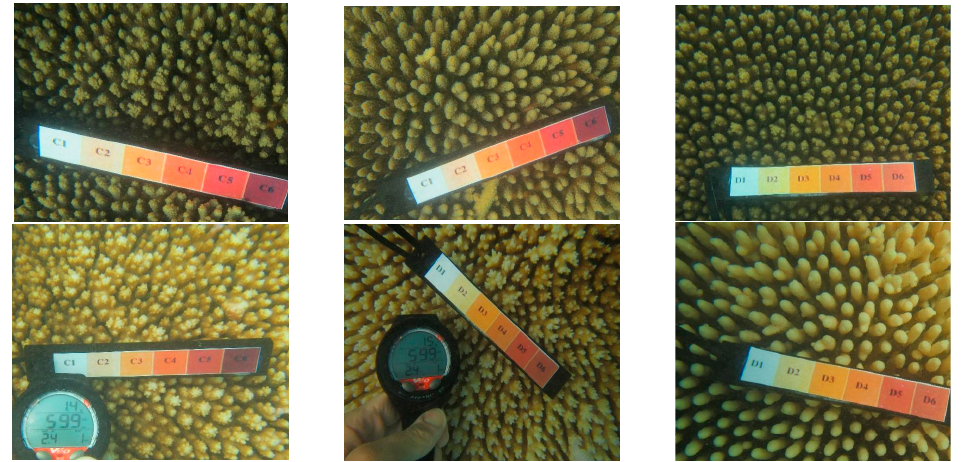
Figure 3. Example of in-water reference data of Acropora with relevant bleaching level: 1 (severely bleached) to 6 (unbleached). Top left —6, bottom right —1. Courtesy of Sam Noonan (AIMS).